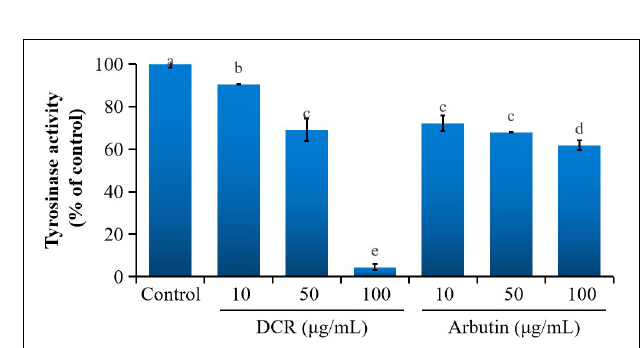
FIGURE 1 | Inhibitory activity of Dryopteris crassirhizoma rhizome (DCR) on mushroom tyrosinase. IC 50 is the concentration of the sample with a mushroom tyrosinase inhibitory activity of 50%. Different lower case letters indicate significant differences ( p < 0.05).